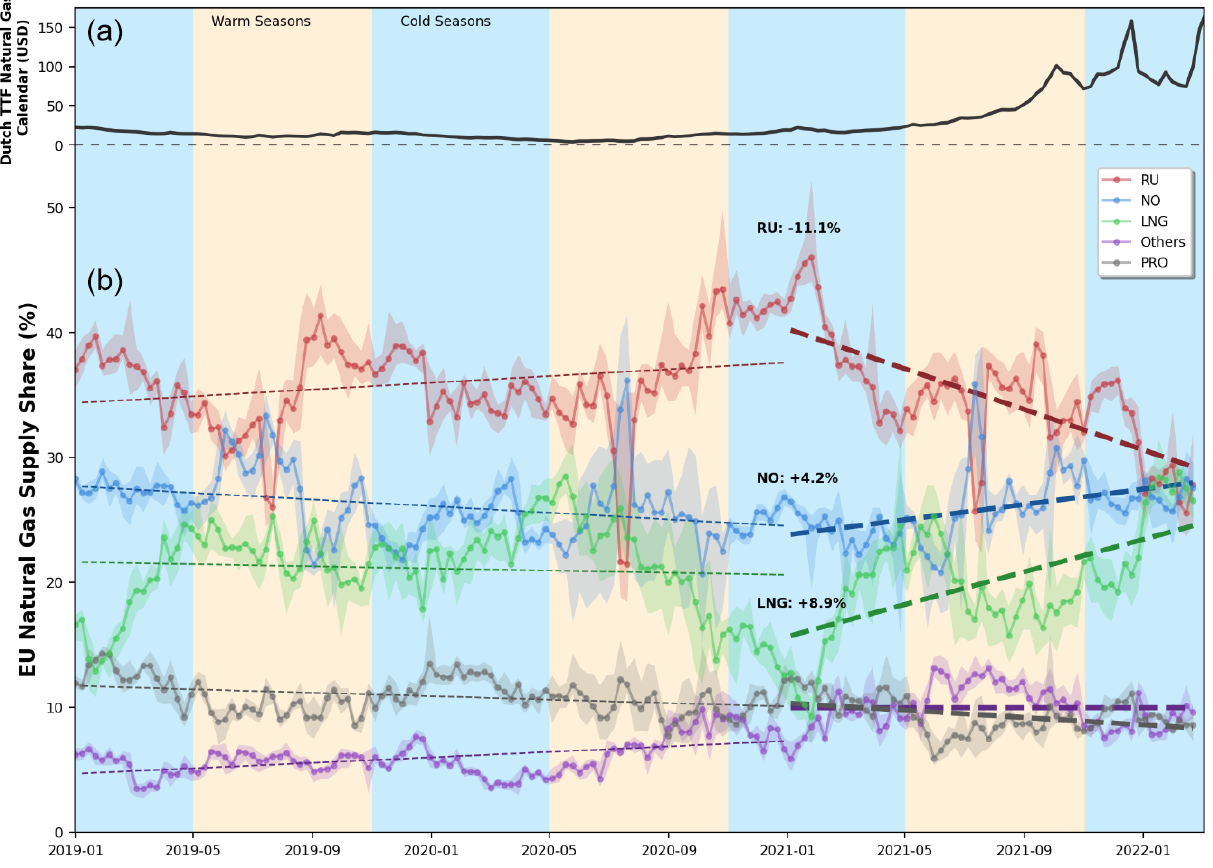
Figure 5. Weekly natural gas supply share trends in the EU27 and UK with the EU gas price. Panel (a) shows the Dutch TTF (Title Transfer Facility) Natural Gas Calendar price as the EU gas price, and panel (b) shows the weekly natural gas supply shares and trends for Russian imports (RU), Norwegian imports (NO), LNG imports (LNG), other imports (Other), and EU production (PRO). The linear trends in different supply sources for the periods from 2019 to 2021 and after 2021 (shown as dashed lines) are also presented. The confidence intervals show the weekly